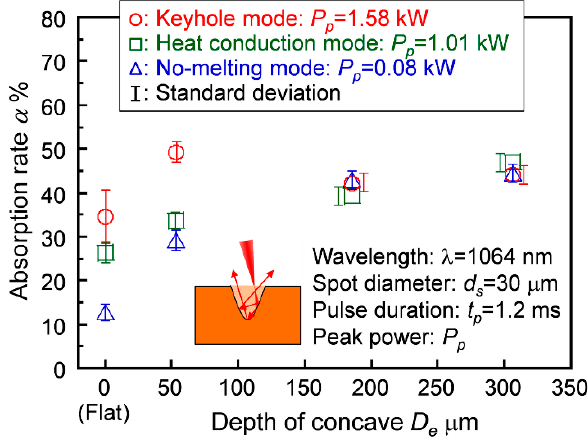
Figure 5. Variations of absorption rate with concave depths for irradiation at bottom center of concave.